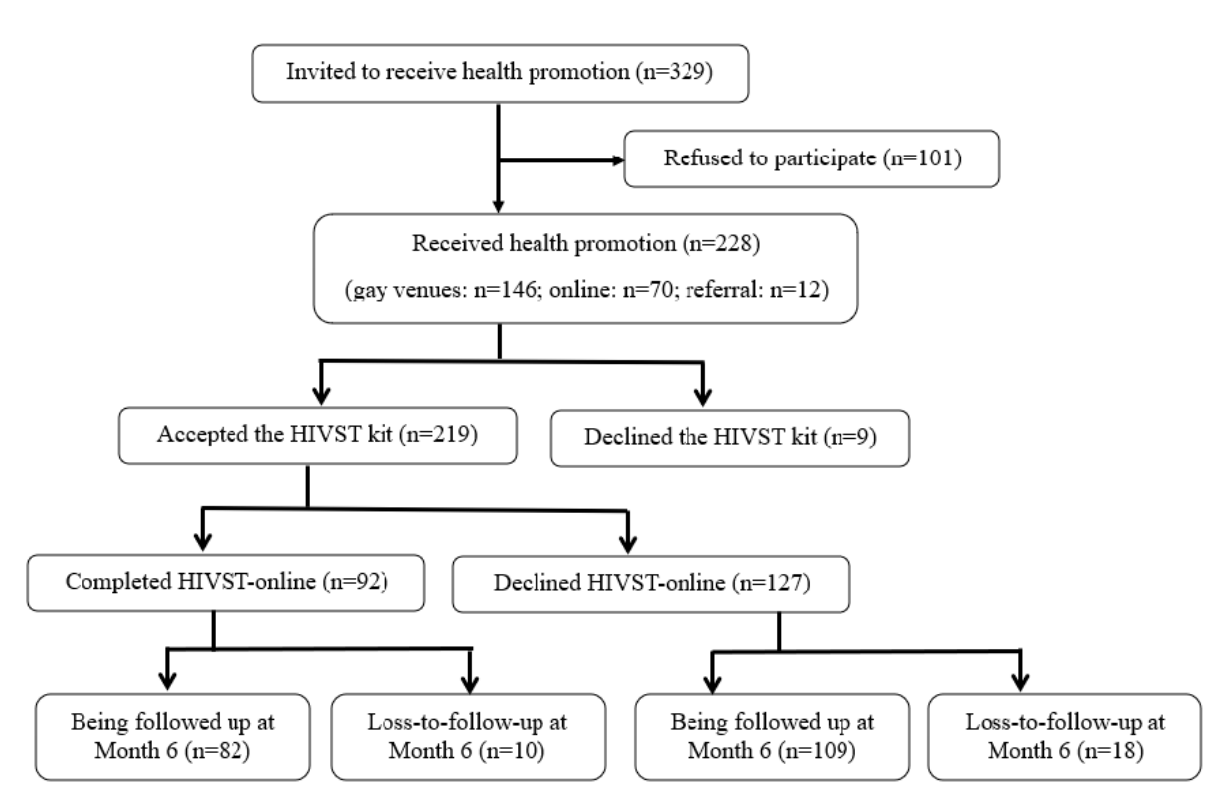
Figure 1. Flow diagram of the recruitment and uptake of human immunodeficiency virus self ‐ testing (HIVST) ‐ online among new ‐ users.